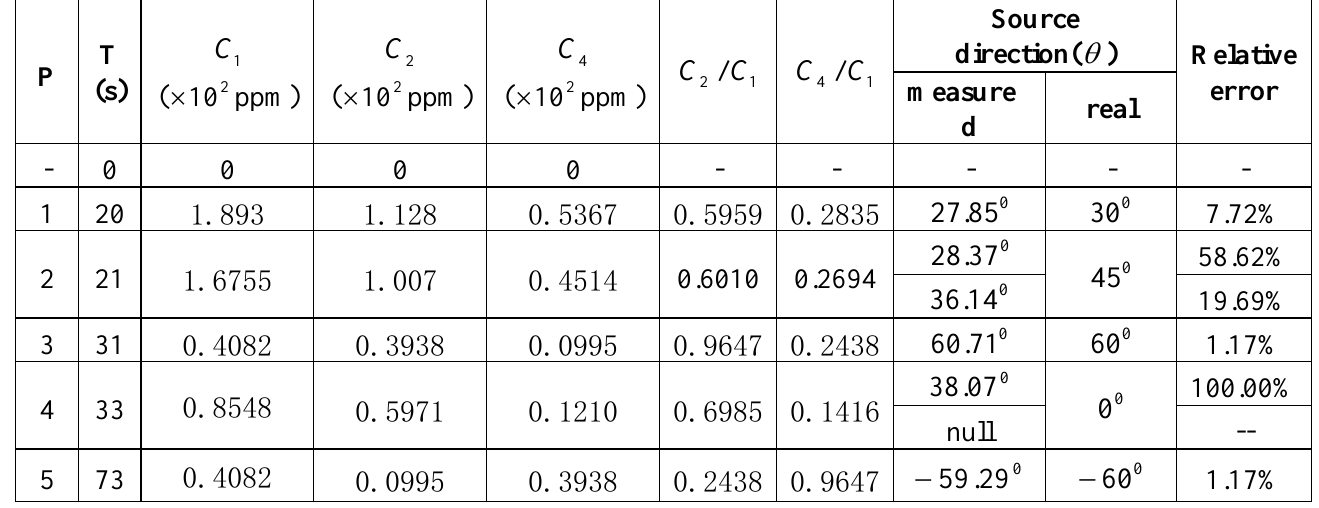
Table 2. Simulation result and errors for dynamic source